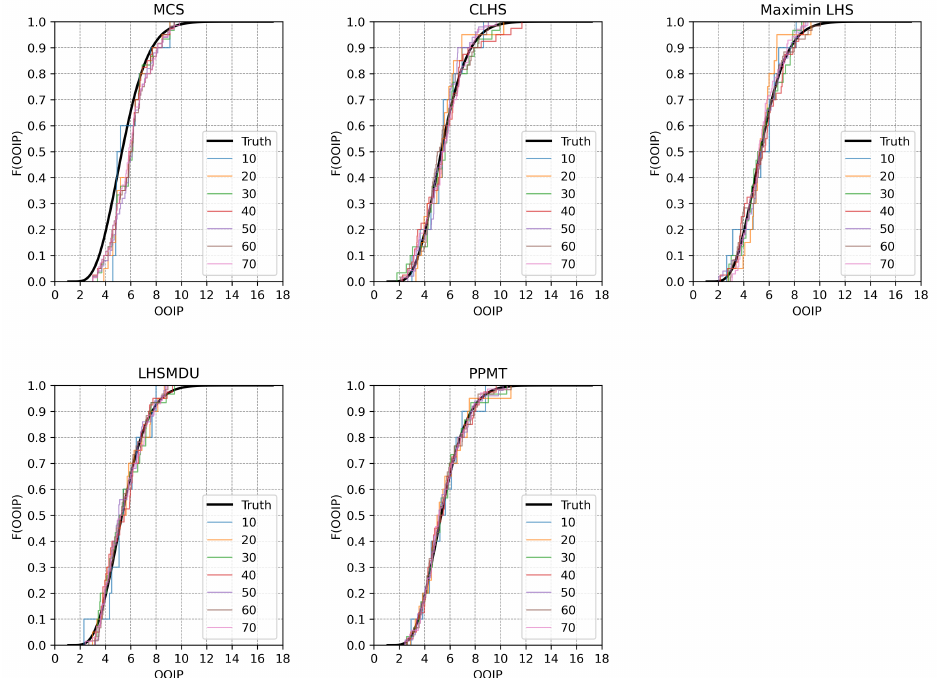
Figure 8. The underlying CDF of the OOIP in the case where the OOIP variables are uncorrelated and the empirical CDFs are generated by each sampling technique considering the small sample